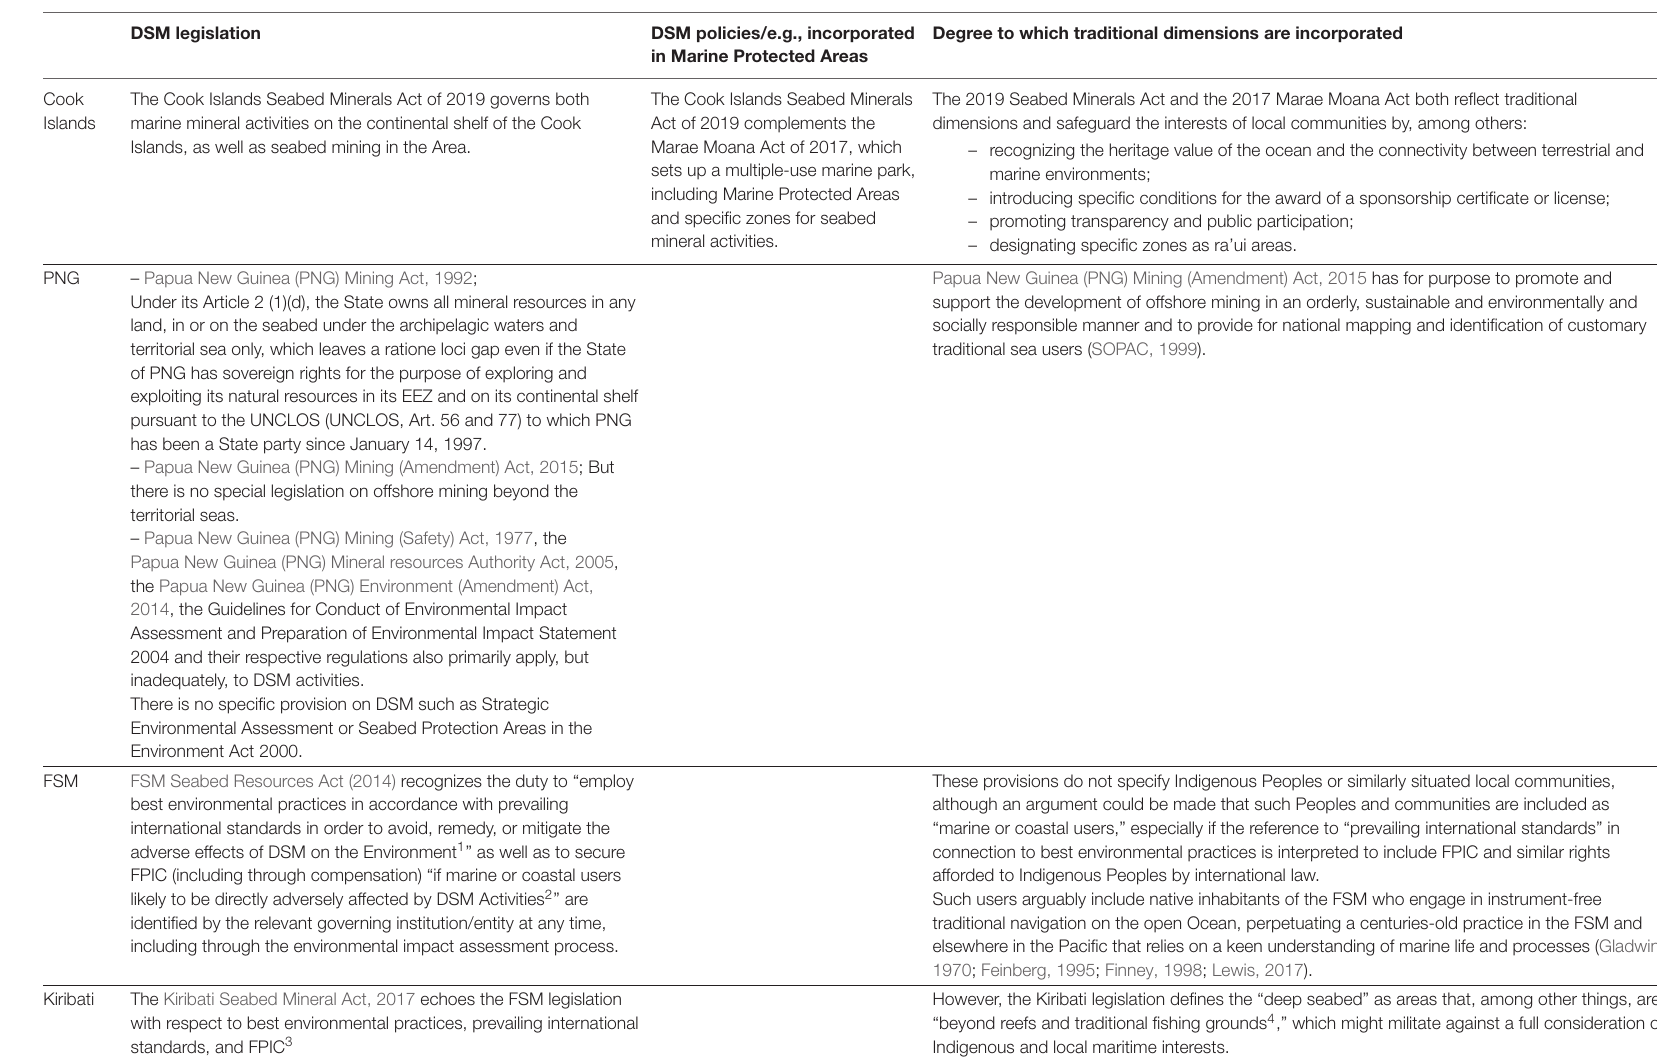
TABLE 2 | Analysis of the actions taken by Pacific Island States towards developing national legislation and policies governing DSM in their EEZs and in the Area and of the degree to which these States incorporate traditional